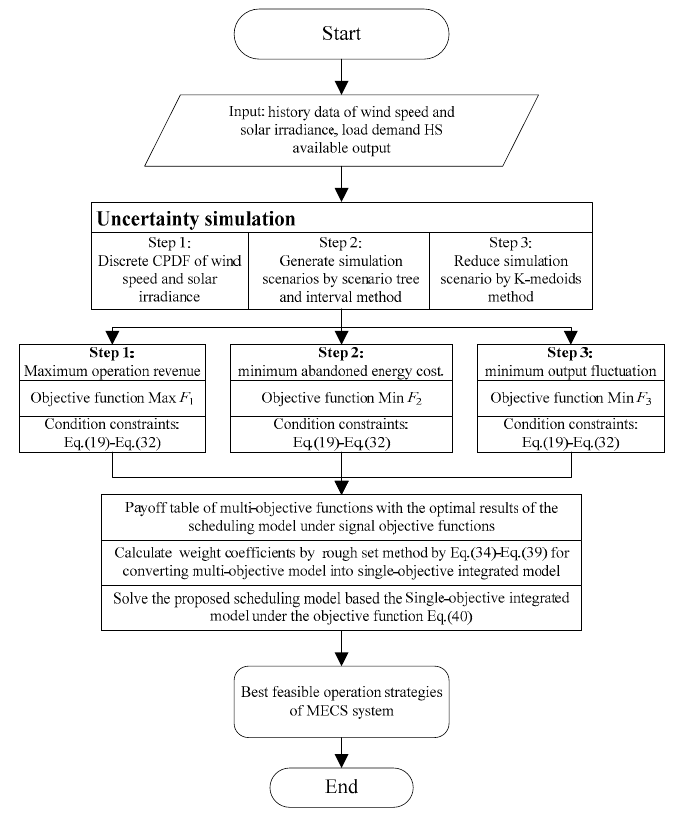
Figure 7. The optimization flowchart for the MECS scheduling model.